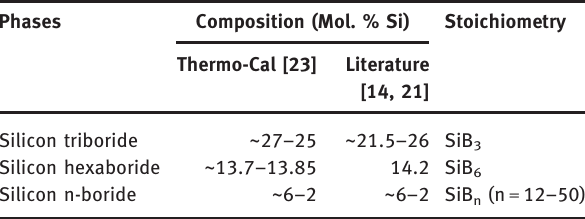
Table 1: Boron-rich phases in the Si-B